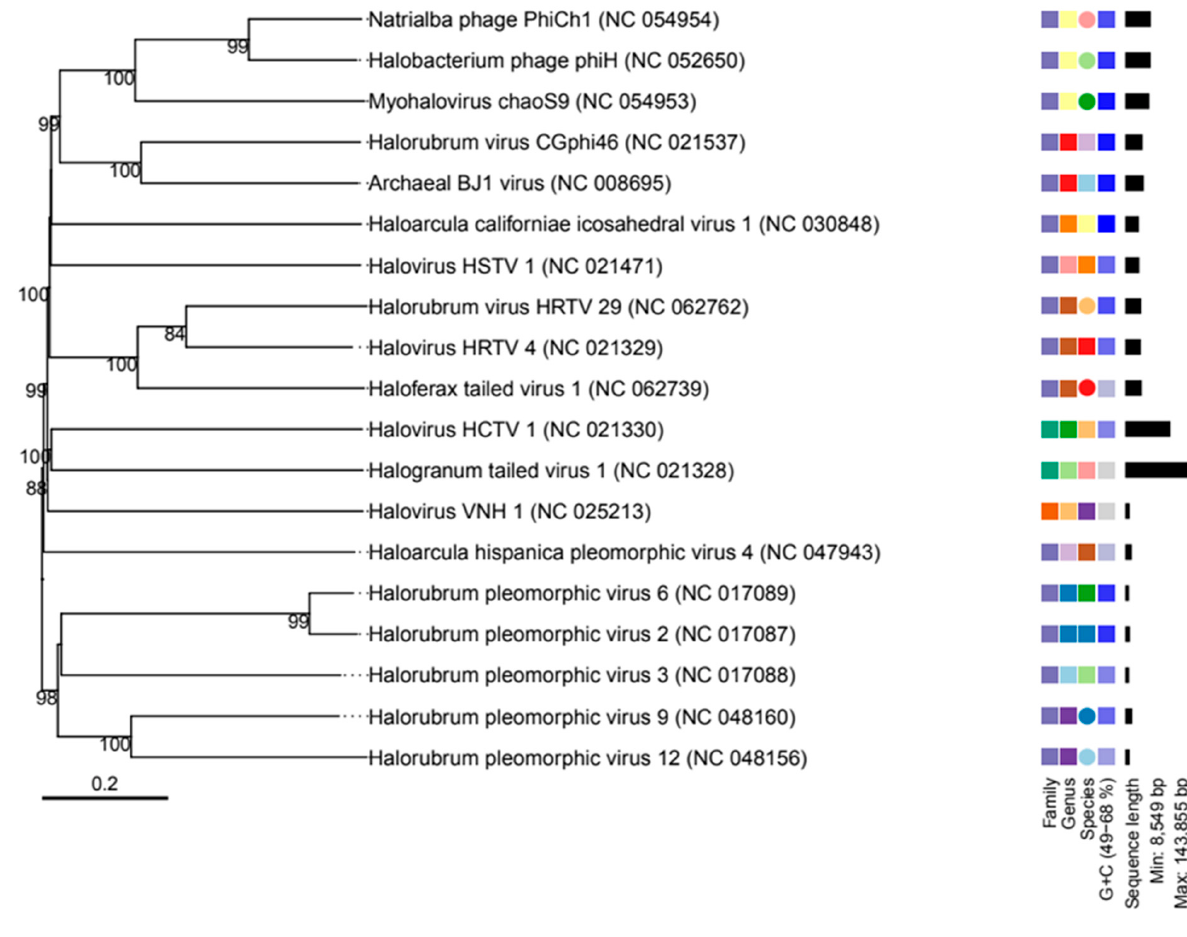
Figure 4. The phylogenetic tree compares archaeal viruses using their genome. The results include phylogenomic trees inferred using the Genome-BLAST Distance Phylogeny method (GBDP), with branch support, as well as suggestions for classifying the species, genus, subfamily, and family level.